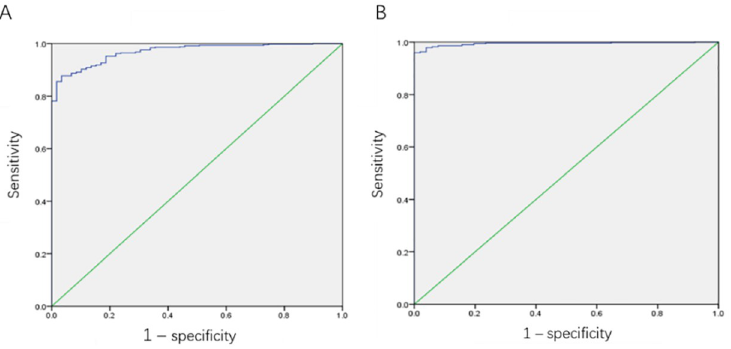
Fig 2. The value of CEP55 as a diagnostic biomarker in LUAD and LUSC. A: ROC curve for evaluating the diagnostic value of CEP55 in LUAD patients, AUC = 0.969; B: ROC curve for evaluating the diagnostic value of CEP55 in LUSC patients, AUC =